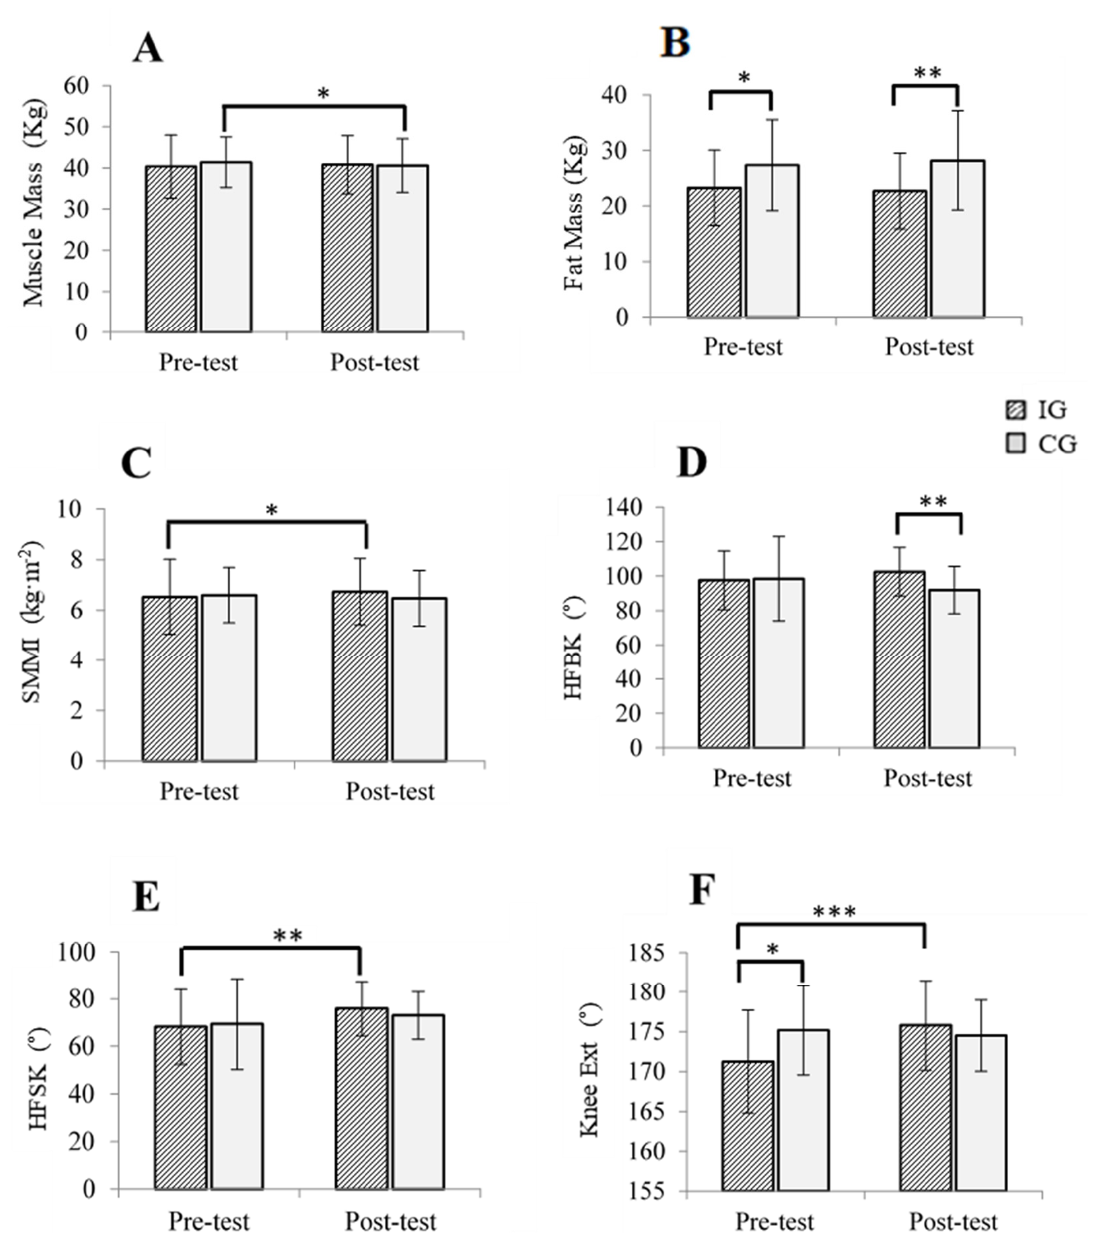
Figure 2. Comparative analysis pre and post-test after PROMUFRA upon: ( A ) muscle mass; ( B ) fat mass; ( C ) SMMI; ( D ) HFBK; ( E ) HFSK; and ( F ) Knee Ext; IG: Intervention Group; CG: Control Group; SMMI: Muscle and Fat Mass are expressed in kg; Skeletal Muscle Mass Index. SMMI is expressed in kg/m 2 ; ROM articular measures are expressed in degrees. ROM: Range of Motion; HFBK: Hip Flexion with Bended Knee ROM; HFSK: Hip Flexion with Straight Knee ROM; Knee Ext: Knee Extension ROM; Statistical significance: * p < 0.05; ** p < 0.01; *** p < 0.001.